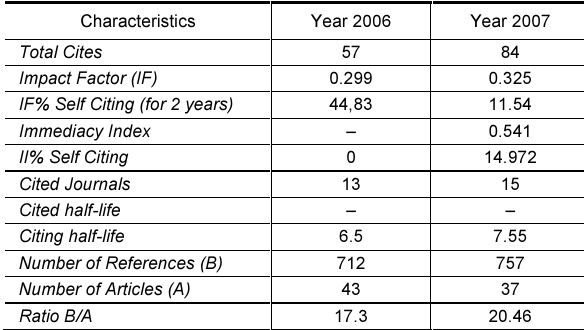
Table 2. The comparison of “Journal of Civil Engineering and Management” analysis results of 2007 and 2006